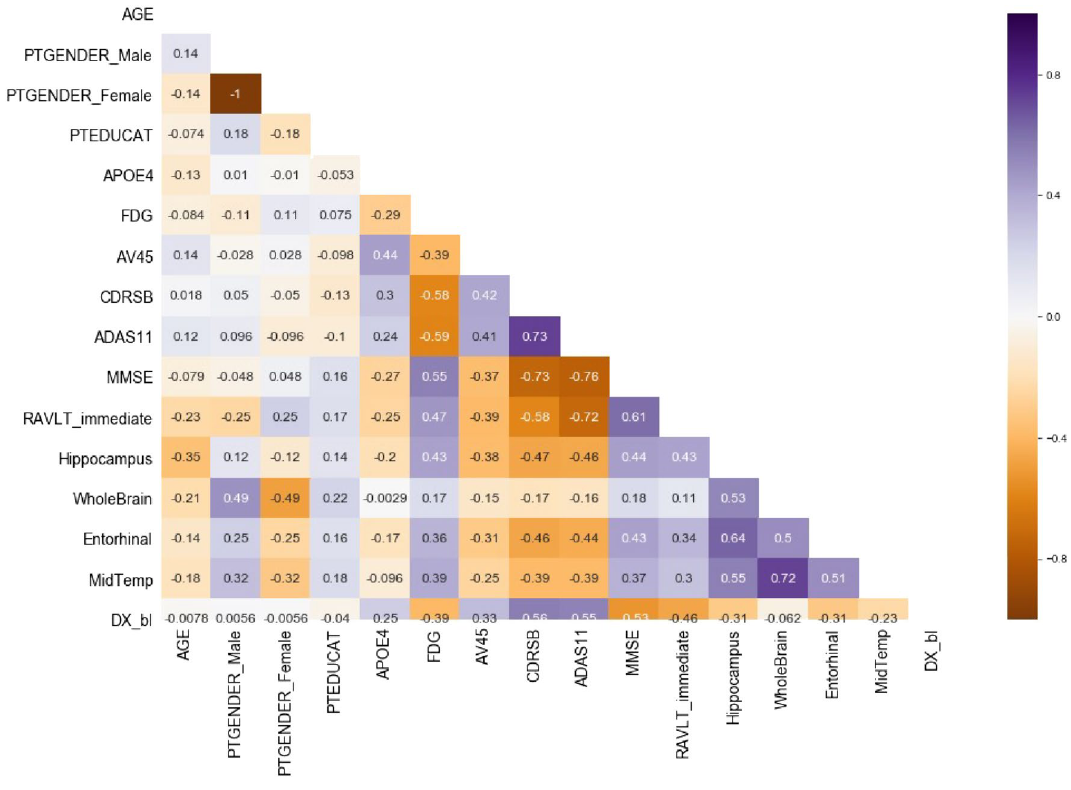
Figure 3. Linear correlation heat map for the data